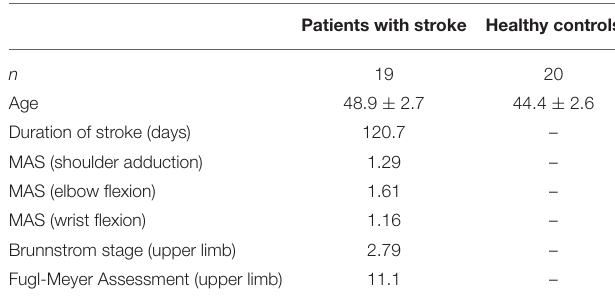
TABLE 1 | Basic information of